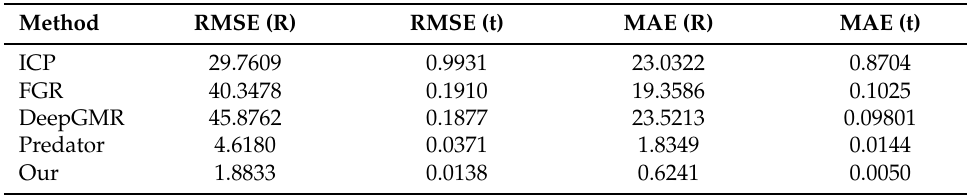
Table 3. The results of point clouds with Gaussian